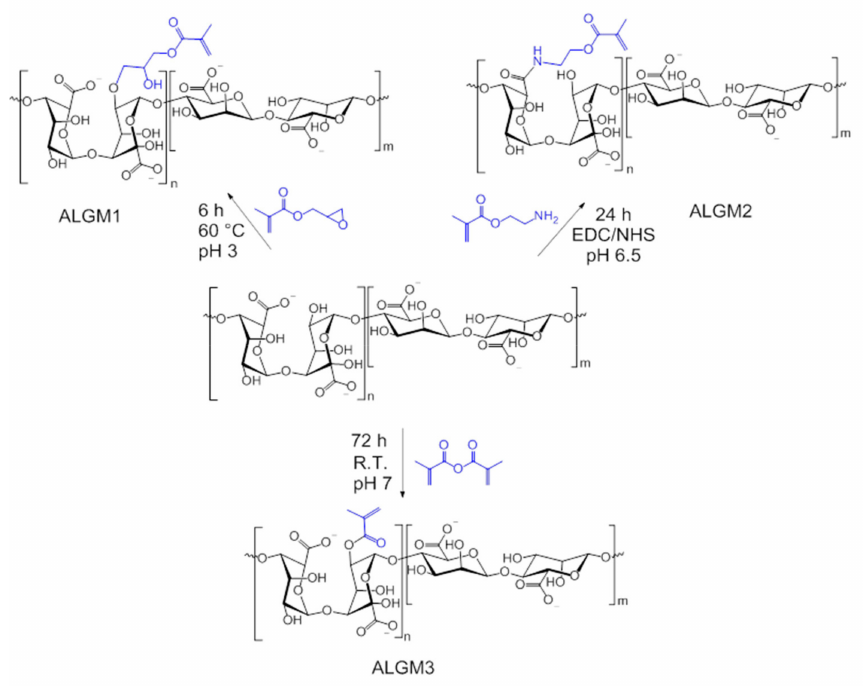
Figure 1. Reaction schemes of the alginate-methacrylate precursor macromers